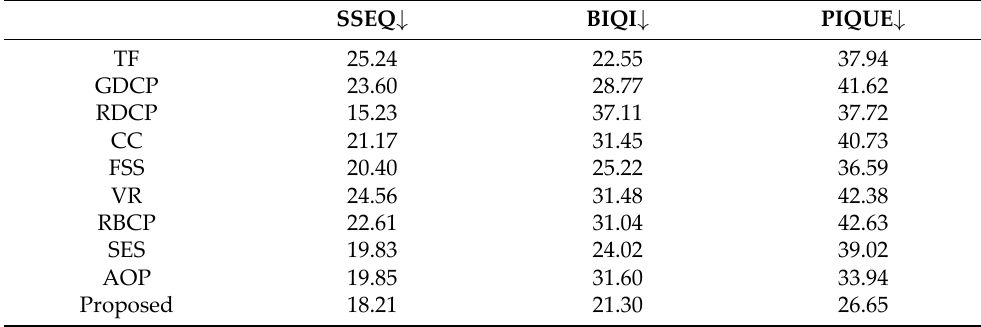
Figure 8. Qualitative comparison results on test set NSI; ( a ) Natural scene sand-dust images; ( b ) TF; ( c ) GDCP; ( d ) RDCP; ( e ) CC; ( f ) FSS ; ( g ) VR; ( h ) RBCP; ( i ) SES; ( j ) AOP; ( k ) Proposed. Table 3. Quantitative comparison of average SSEQ, BIQI, and PIQUE scores for the comparison algorithms on test set